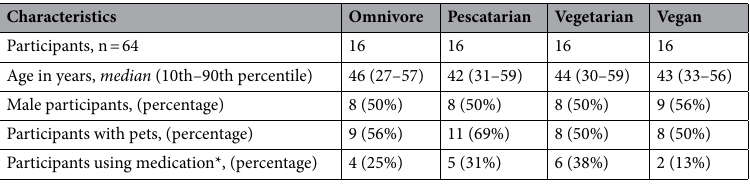
Table 2. Participant characteristics of the subset selected for ResCap. *Medication other than antibiotics, proton pump inhibitors, insulin and cancer treatment.